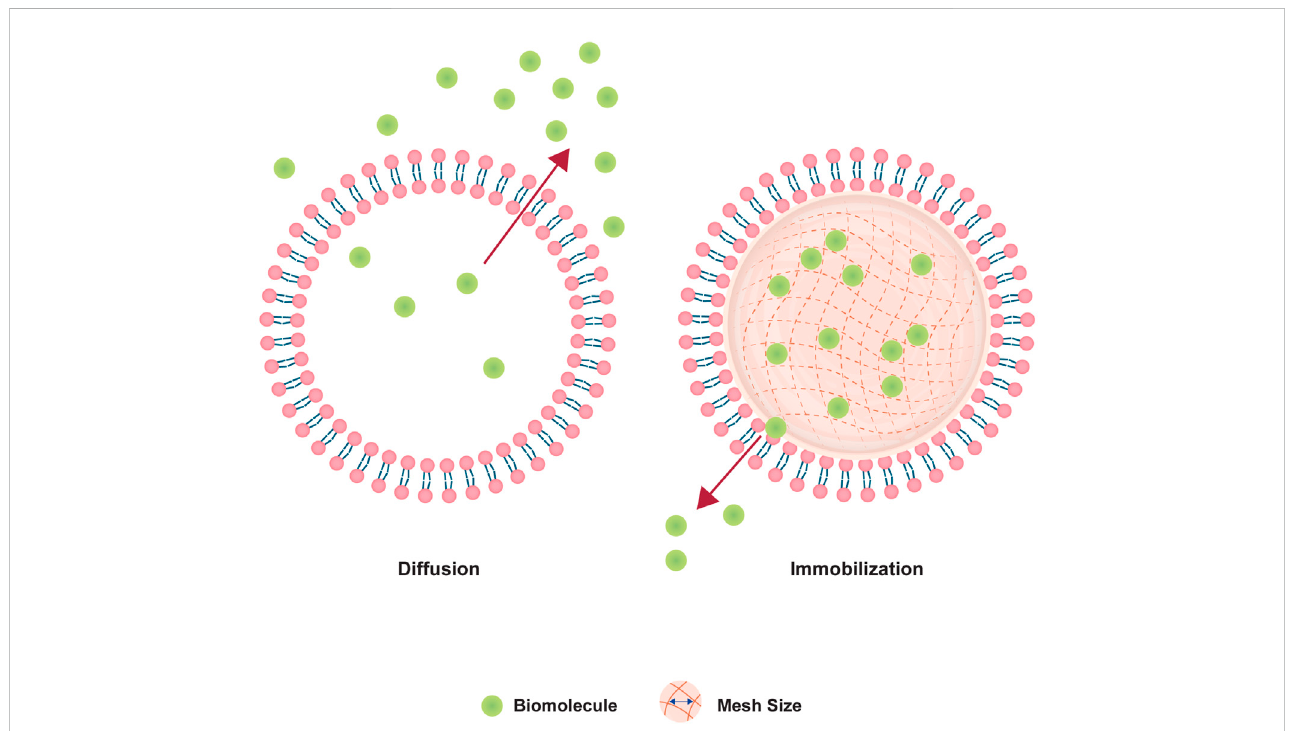
FIGURE 5 Schematic depicting the effect of crosslinking nanogel core on diffusion of encapsulated biomolecule.